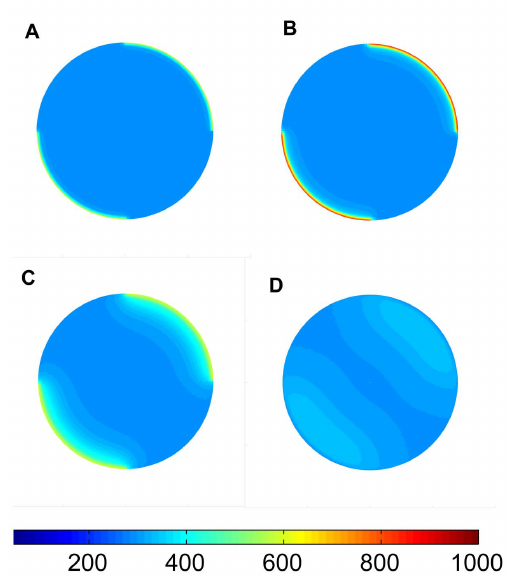
Figure 2. Simulated tree-stem temperature distribution in various time steps. A. The heat-up phase (t=20 sec). B. The peak temperature point (t=80 sec). C. The beginning of cool-down phase (t=100 sec). D. After long cool-down period (t=200 sec). Heating was provided in a heterogeneous way around the virtual stem section, with heat forcing at the upper right and lower left quadrant of the stem and no heat (ambient room temperature) prescribed at the upper left and lower right quadrants. The colors represent temperatures, colorbar is in K.